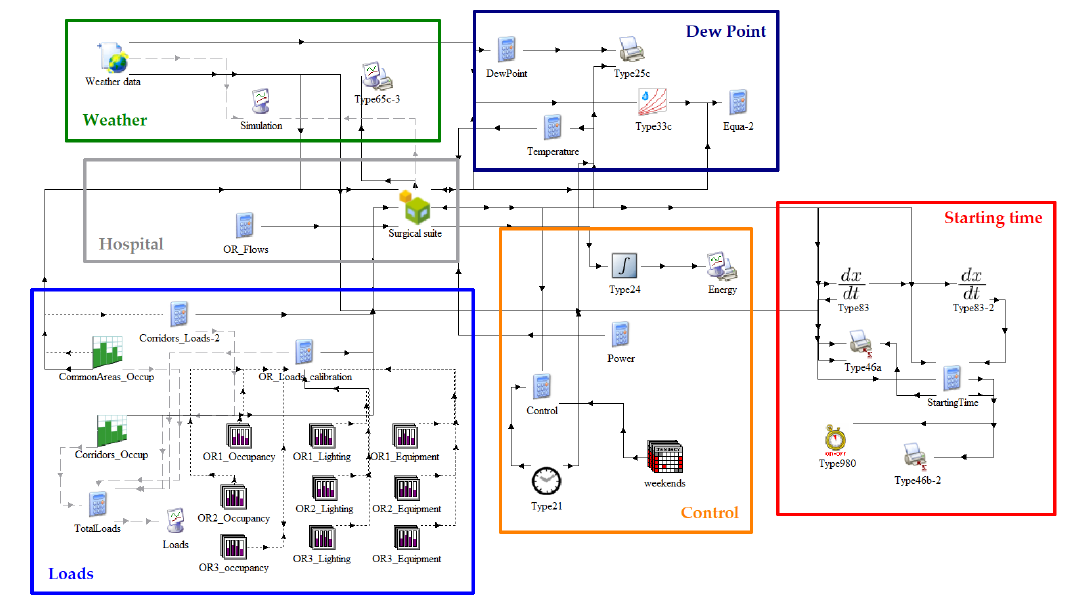
Figure 3. Simulation diagram implemented in TRNSYS.